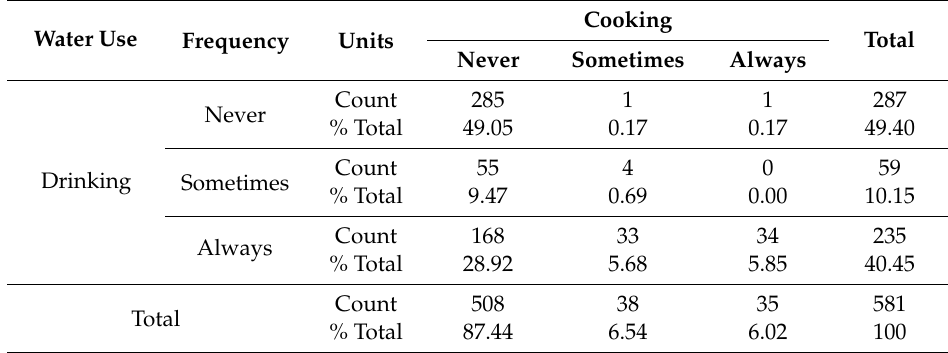
Figure 1. Perceived quality of the local water supply network for drinking ( left ) and for cooking ( right ) (n = 581). Table 2. Frequency of consumption of bottled water for drinking and for cooking (n =